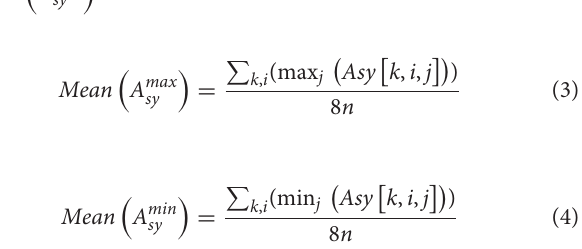
maximum asymmetry index from all the trials and its minimum as Mean (cid:16) A min sy (cid:17)